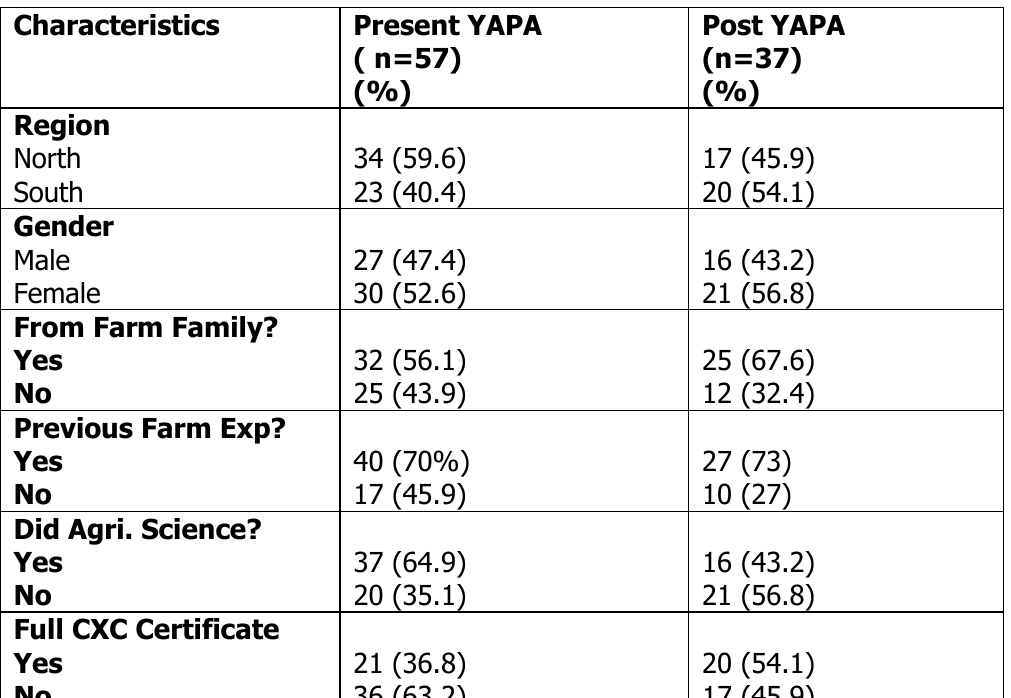
Characteristics of Trainees